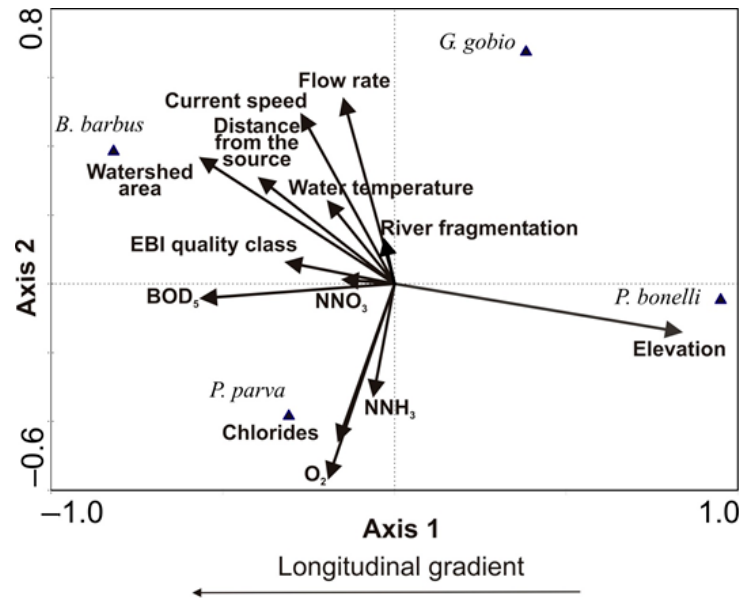
Figure 8. Canonical Correspondence Analysis results: biplot of fish and environmental variables for the census periods 1998–2004, 2005–2011, 2012–2018. Table 1. Canonical and correlation coefficients of environmental variables with axis. p < 0.05 is in bold.